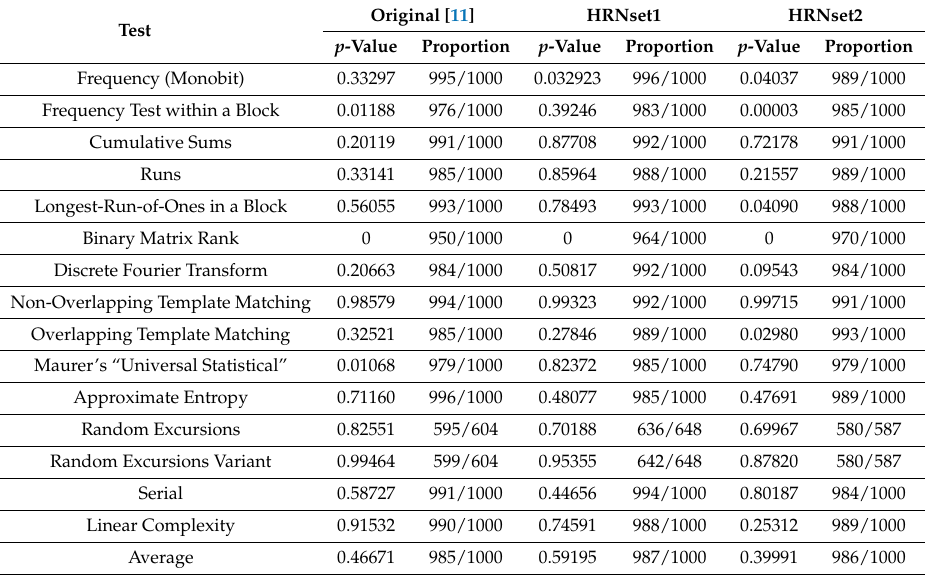
Table 9. NIST tests for the binary sequences generated by the Hindmarsh–Rose neural network for the state variable x , and for the sets of values given in Table